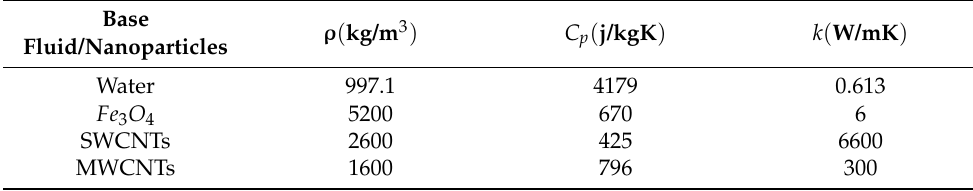
Table 2. The numerical properties of water, CNTs and Fe 3 O 4